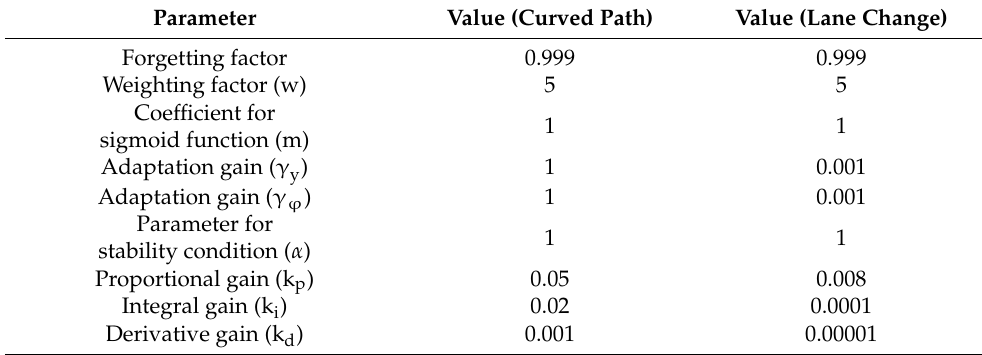
Table 3. Control parameters.